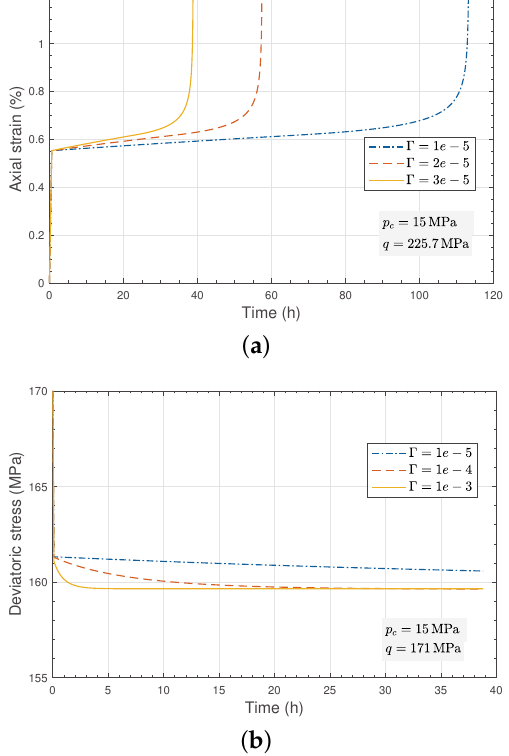
Figure 7. Parametric studies on the influence of the parameters Γ . ( a ) Creep test; ( b ) Relaxation test.